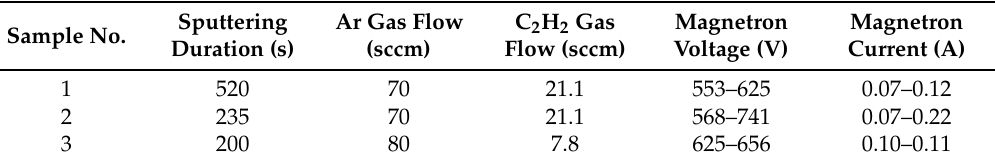
Table 3. Deposition conditions of DLC:Ag